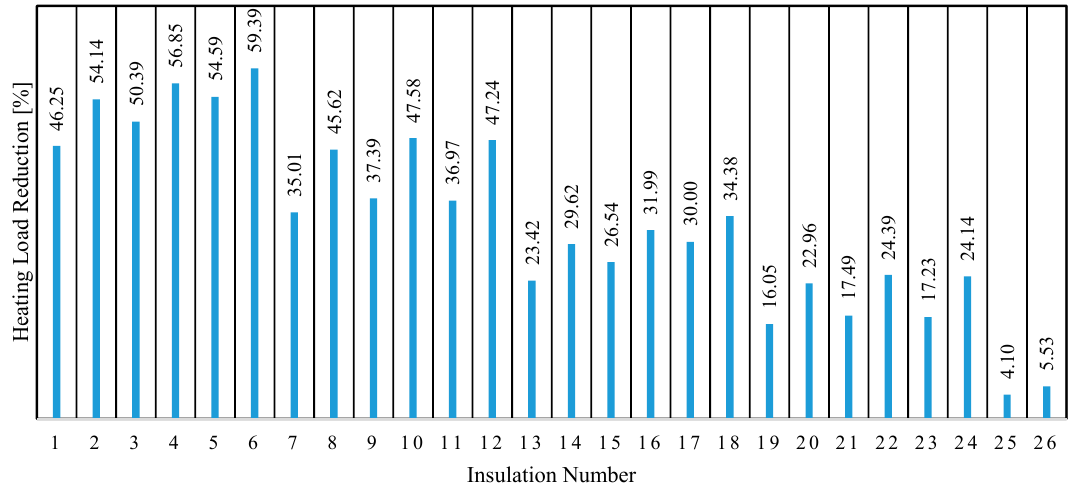
Figure 16. Desired load reduction for different retrofitted residential buildings scenarios.